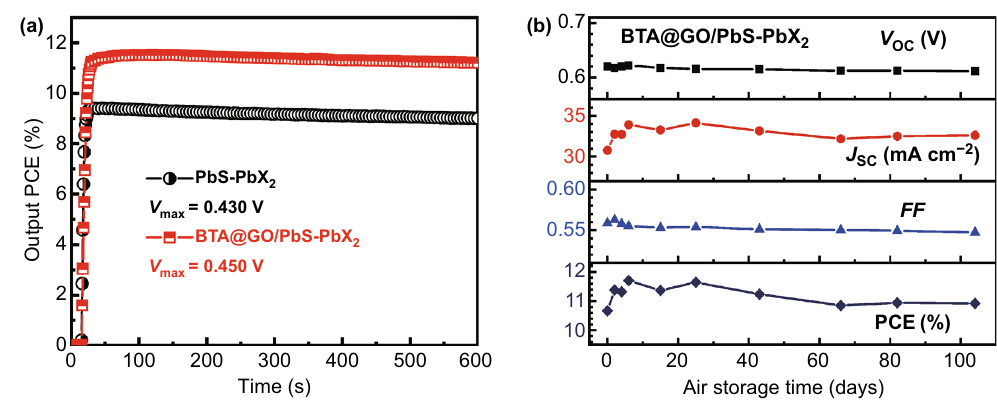
Fig. 7 a Stable output test of PbS-PbX 2 CQDs film and BTA@GO/PbS-PbX 2 hybrid CQDs film-based CQDSCs at maximum output power condition which were measured under AM1.5 G 100 mW cm −2 light soaking in air. b Air storage stability of the BTA@GO/PbS-PbX 2 hybrid CQDs film-based CQDSCs with indoor relative humidity of